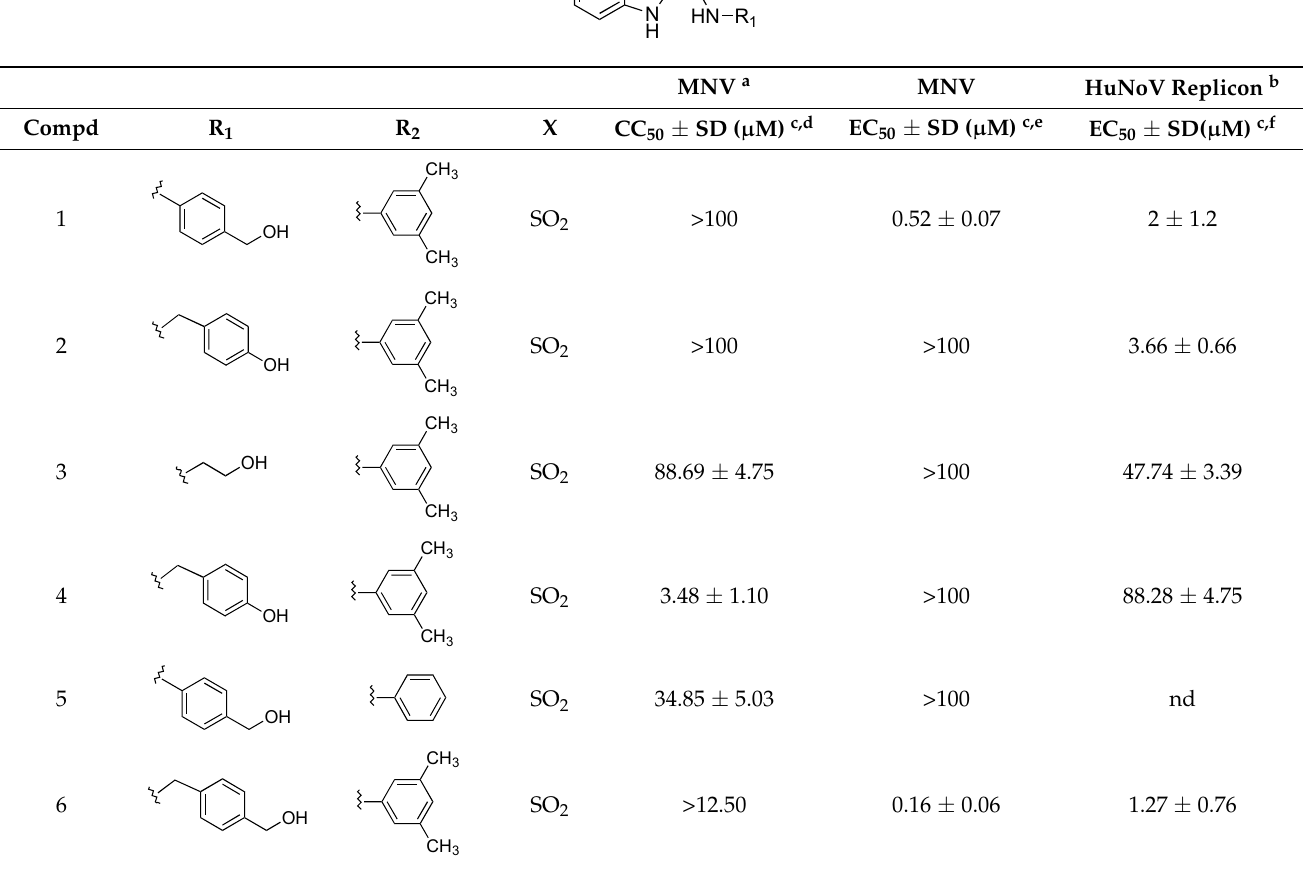
Table 1. Anti ‐ norovirus activity by compounds 1 – 11 .